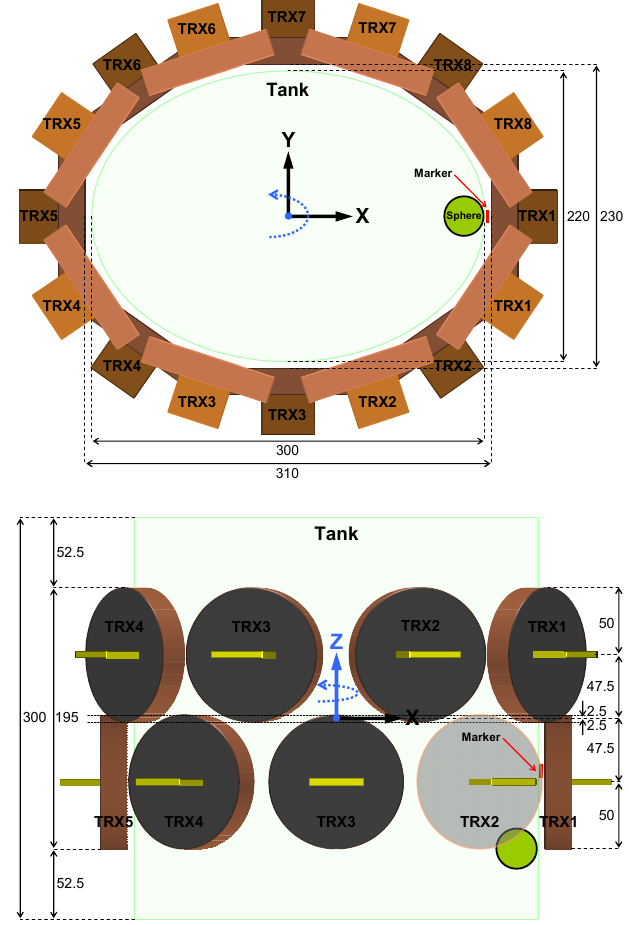
Fig. 3: The mechanical body and elliptical coil system of the used MITS tomograph. The two-plane transceiver array is fitted in a custom-built, robust wooden table which has some kind of opening mechanism that allows positioning a test person or a large test phantom into the coil system.